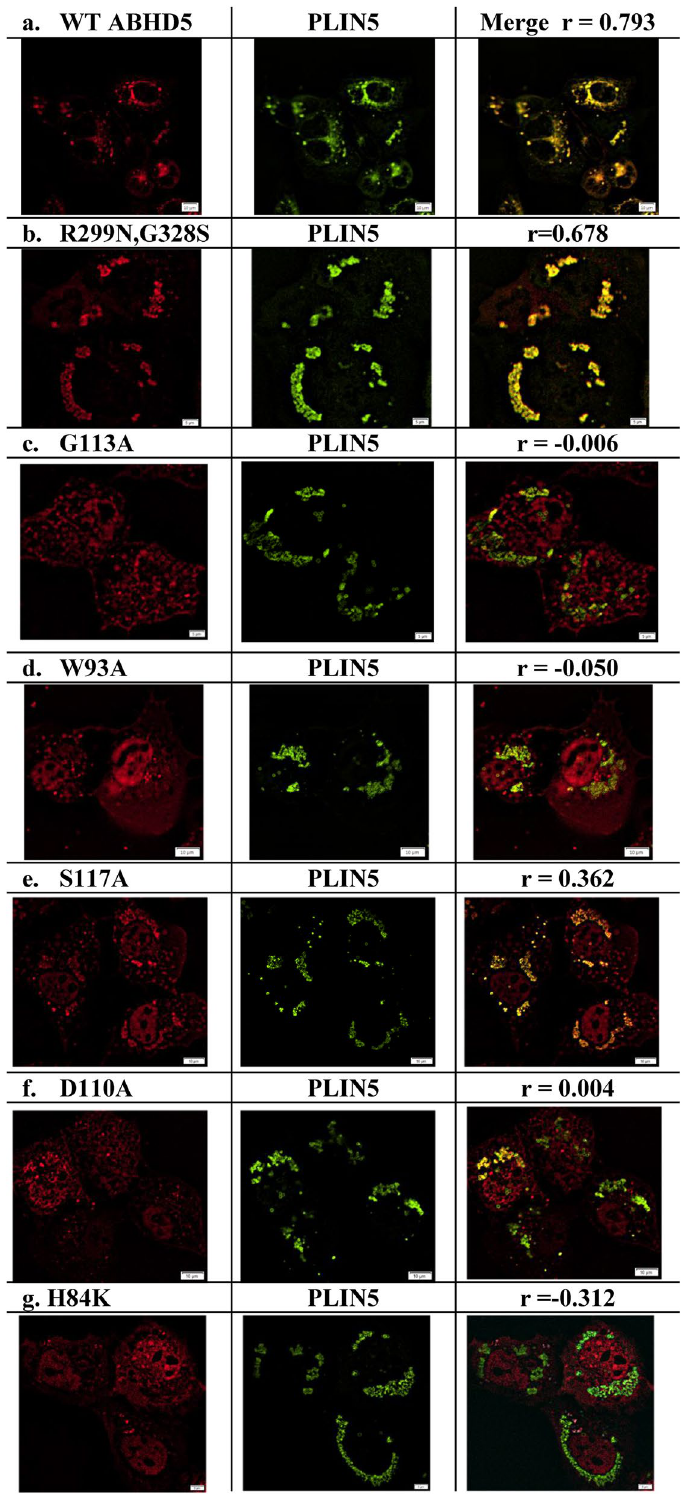
Figure 4. Subcellular localization of ABHD5 mutants in lipid droplet formation assays. Cos7 cells were cotransfected with cherry-tagged ABHD5 or ABHD5 mutants, PLIN5-EYFP and ATGL-ECFP and exposed to oleic acid overnight. Cells were fixed and imaged by confocal microscopy using a ×60 water immersion objective. Representative regions of interest containing triply-transected cells are shown. All mutants were defective in preventing lipid droplet formation as indicated by clusters of PLIN5-containing LD. Colocalization between ABHD5 and PLIN5 was performed using Pearson’s regression (r) in the cellSens software